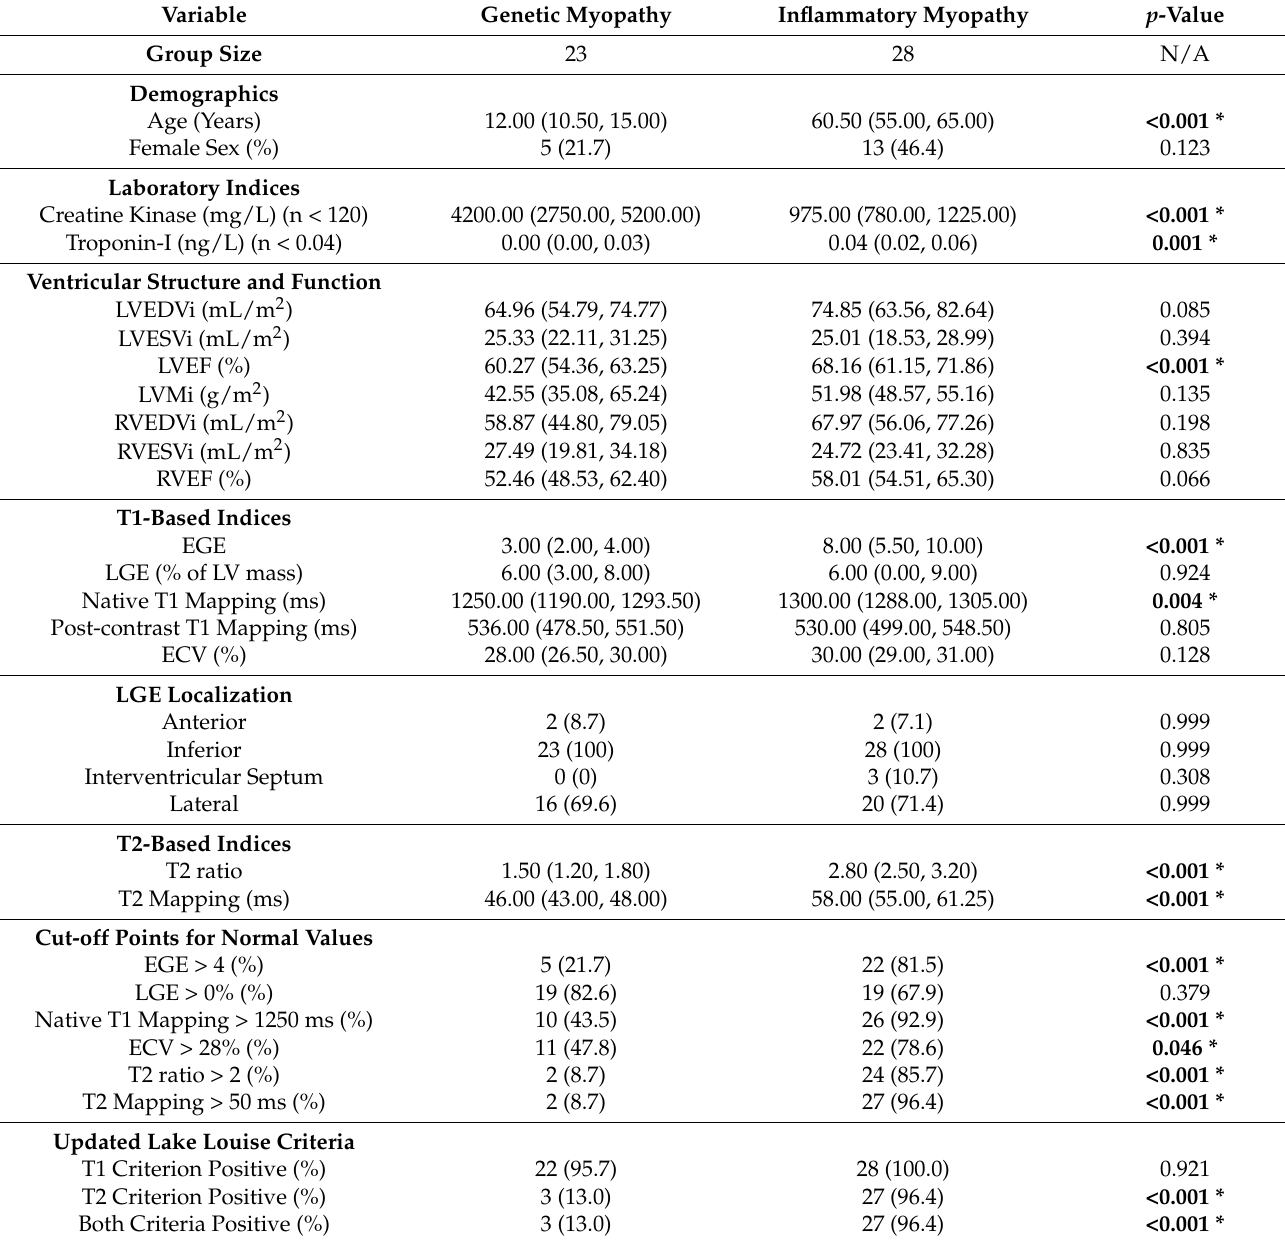
Table 3. Comparison of patients with genetic and inflammatory myopathies. * p ≤